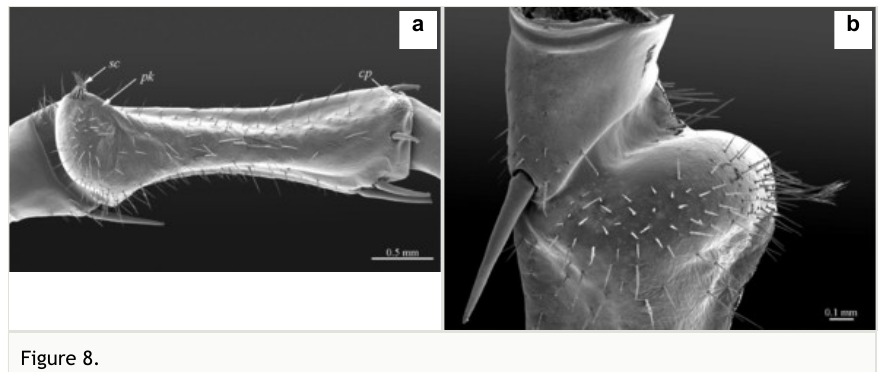
Figure 8. Eupolybothrus cavernicolus Komerički & Stoev sp. n., male paratype. a : prefemur 15, mesoventral view. Abbreviations: prefemoral knob ( pk ), circular setose protuberance ( cp ), cluster of setae ( sc ).